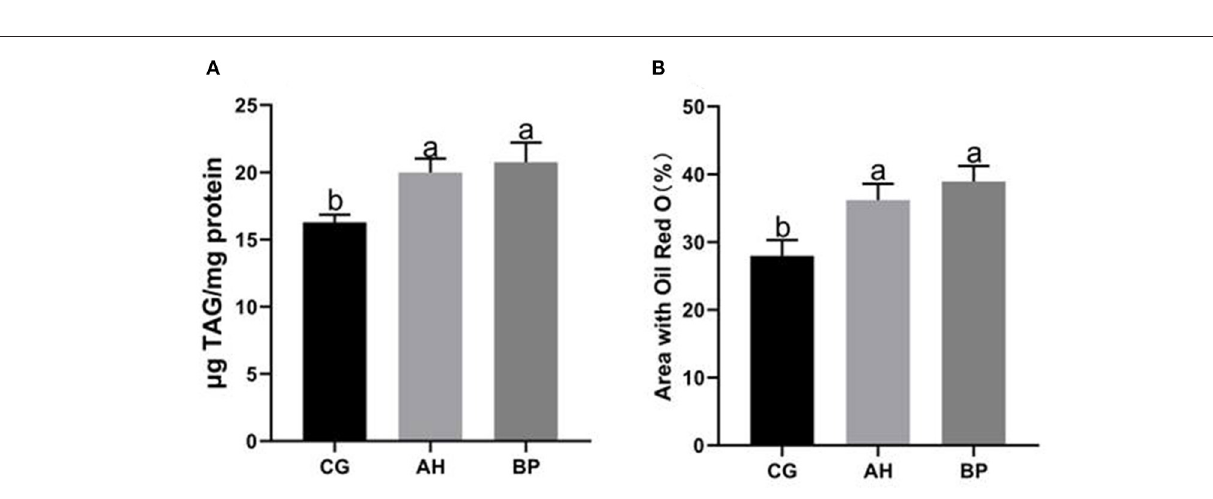
FIGURE 4 | Effect of alfalfa flavone and hybrid Broussonetia papyrifera flavone on TAG content in gMECs. (A) The TAG content in gMECs; (B) Percentage area covered with Oil Red O staining as measured using ImageJ software. CG: control group. AH: the medium contains 4 µ mol/L of alfalfa flavone; BP: the medium contains 4 µ mol/L of hybrid Broussonetia papyrifera flavone. Mean values without common superscript (a and b) differ significantly among CG, AH, and BP groups ( p <